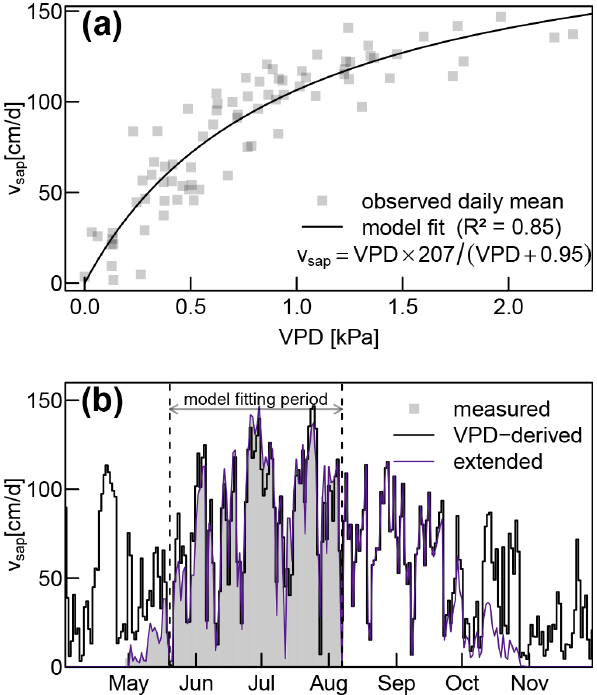
Figure A4. (a) Relationship between daily mean values of vapor pressure deficit (VPD) and sap flow velocity ( v sap ). (b) Time series of measured and VPD-derived daily mean v sap . The model fitting period excludes the time before completion of leaf flush. The pur- ple line shows the extended data as used for the xylem water age computations (values before April and after November are also